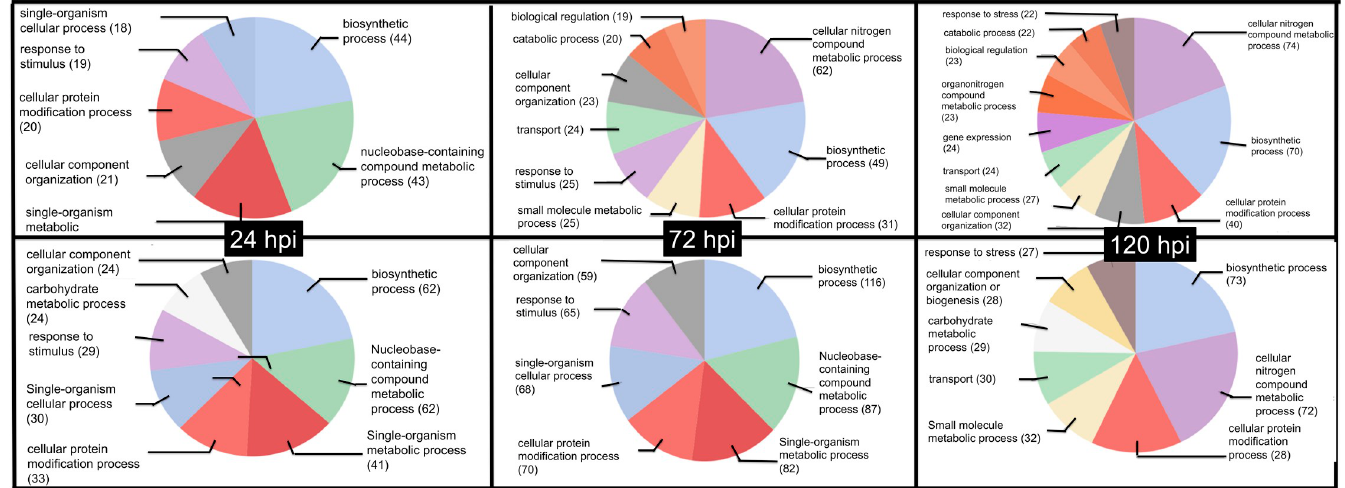
Fig 4. GO distribution for biological process of DEG in oil palm clones during interaction process with P . palmivora . Top panel Ortet 34 (Resistant), Bottom panel Ortet 57 susceptible.